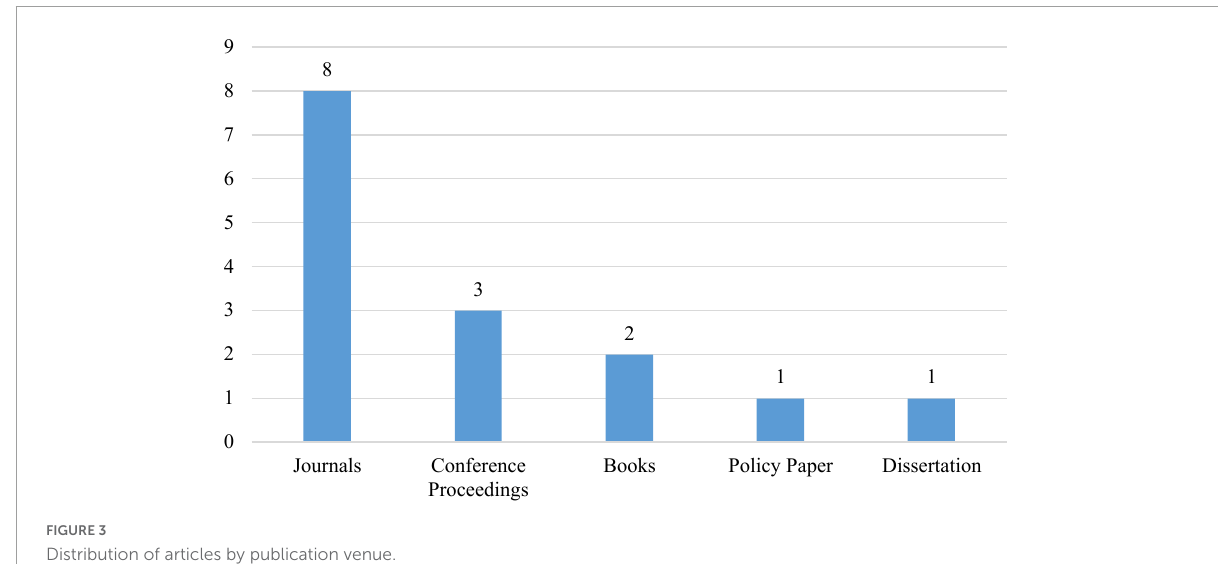
FIGURE3 Distribution of articles by publication venue.